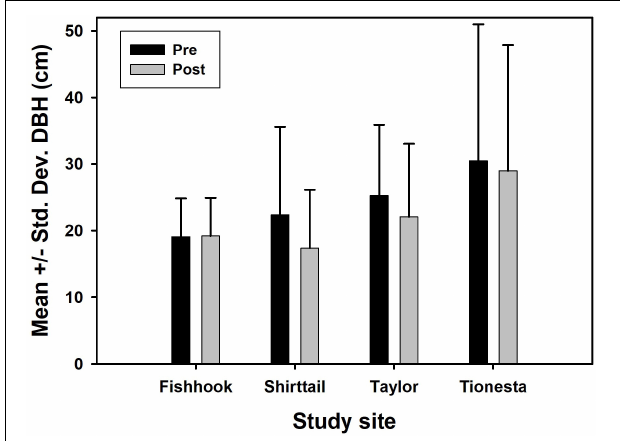
FIGURE 8 | Pre- and postdisturbance mean tree diameter at 1.35 m (DBH), in cm, in the four study sites. Error bars represent one standard